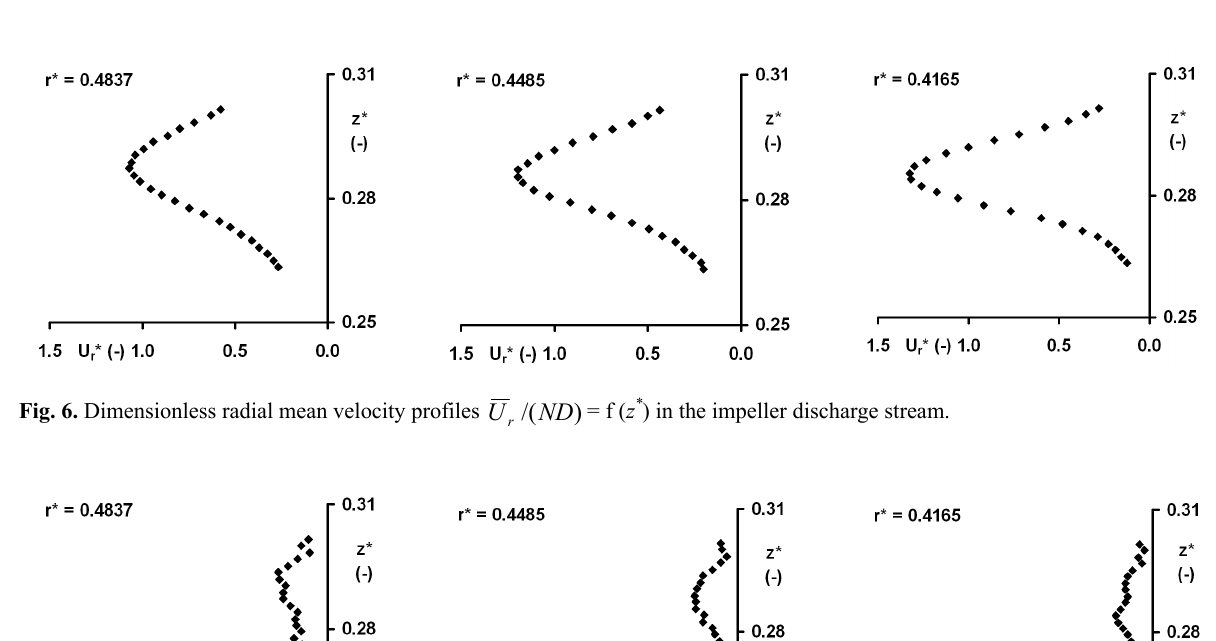
= f ( r * , z * ) in the impeller discharge stream. ax